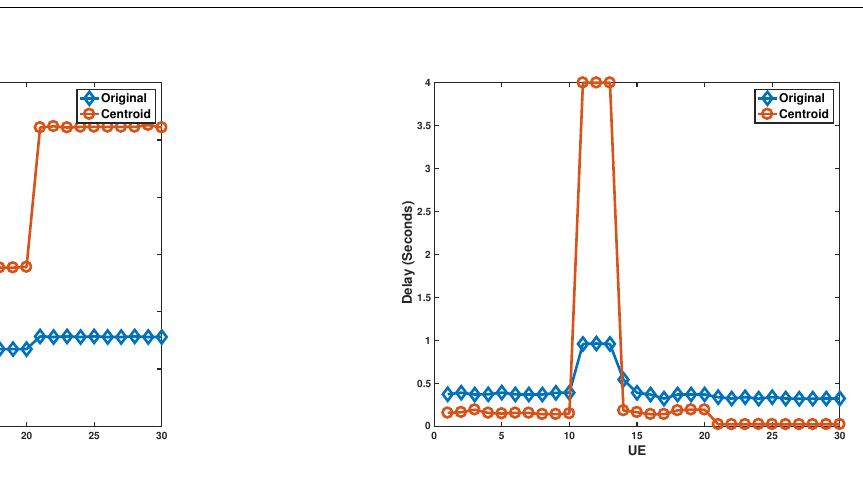
Figure 5. Throughput Performance vs. Number of UEs Figure 6. Delay Performance vs. Number of UEs